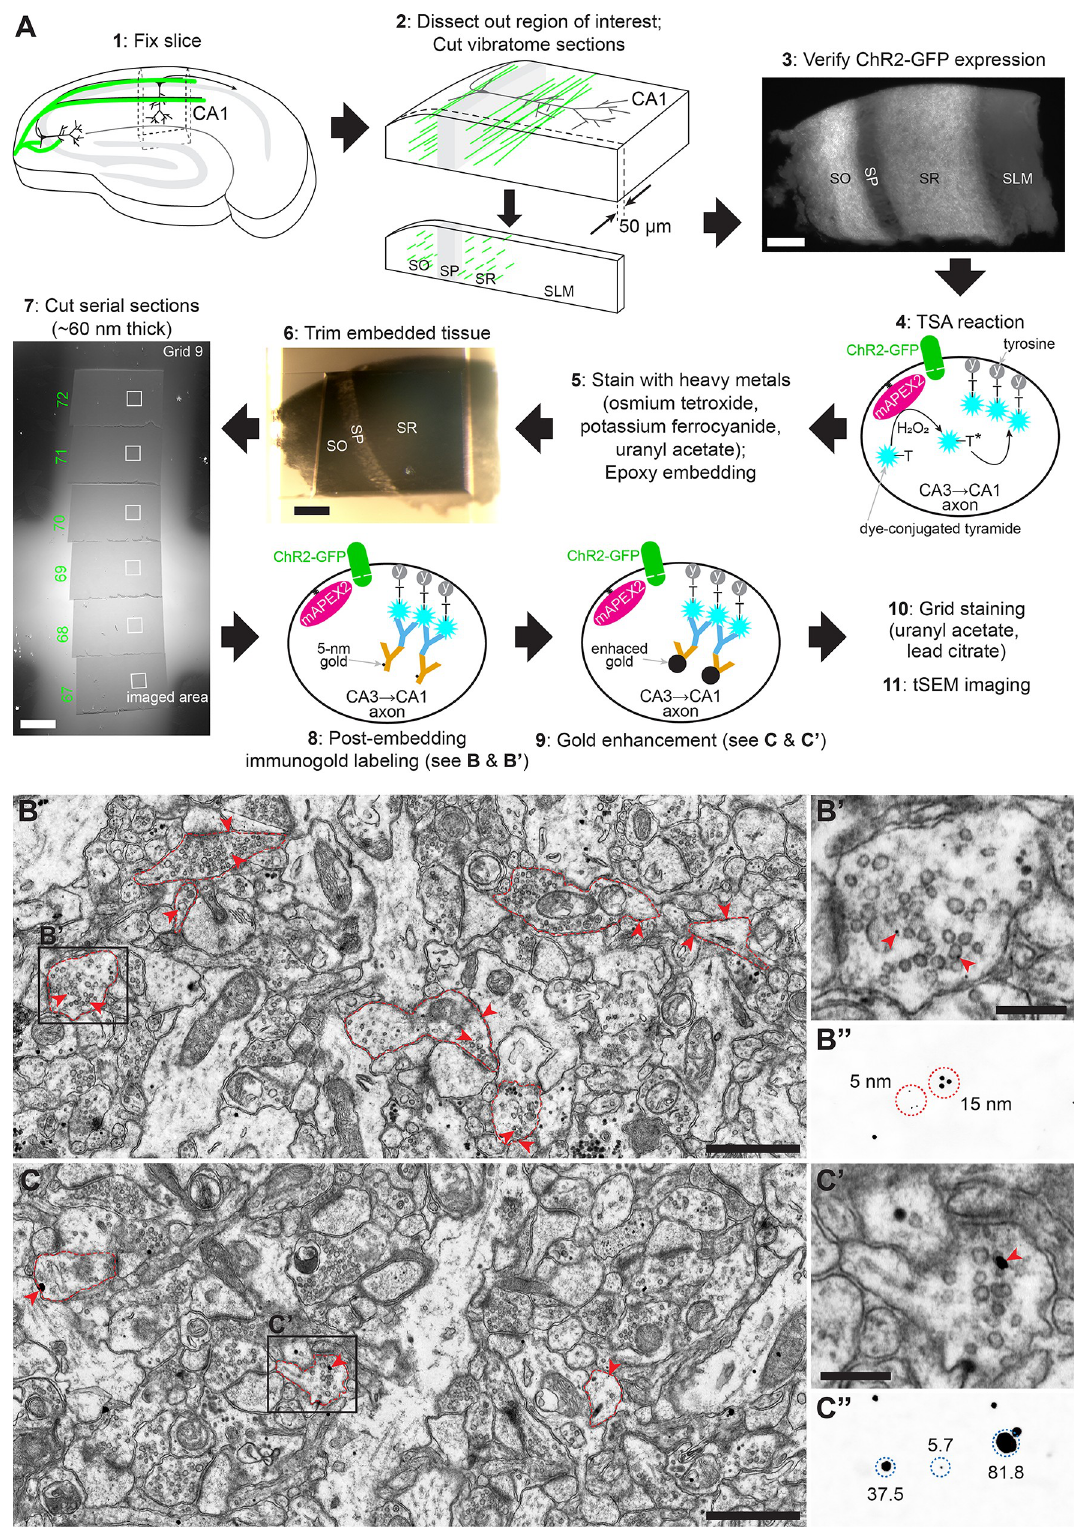
Fig 3. mAPEX2-catalyzed labeling and 3DEM identification of rAAV-targeted axons. ( A ) Workflow for processing of hippocampal slices following optical L-LTP. Vibratome sections from the fixed area CA1 underwent tyramide signal